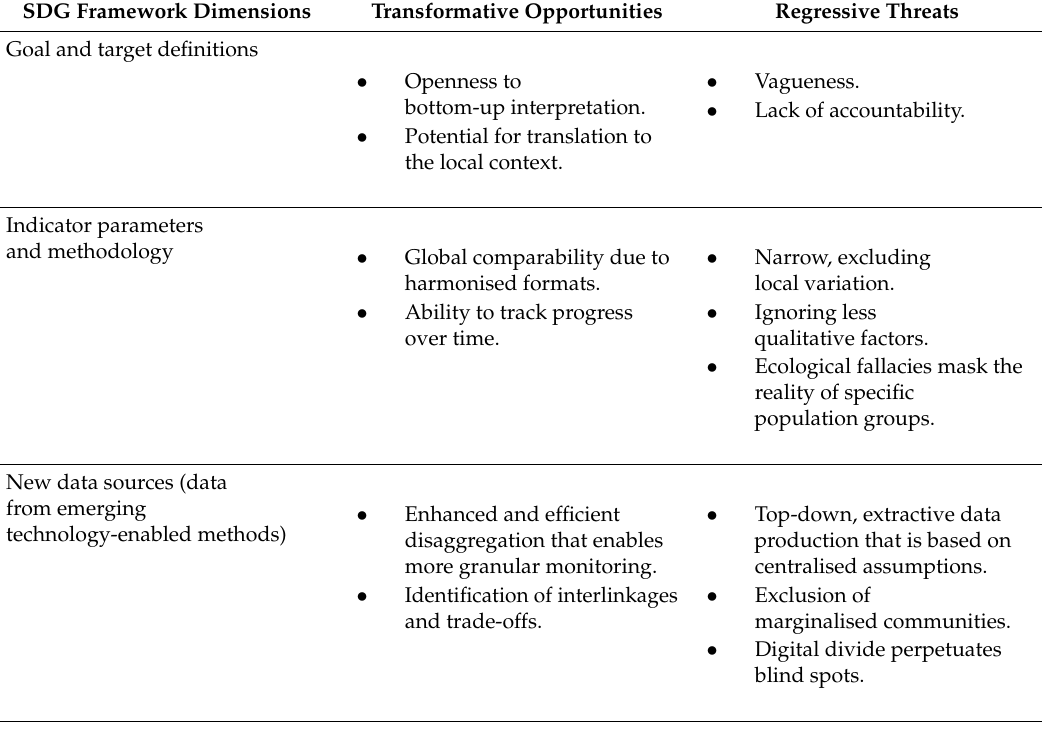
Table 1. Summary table: inherent tensions within the Sustainable Development Goal (SDG)